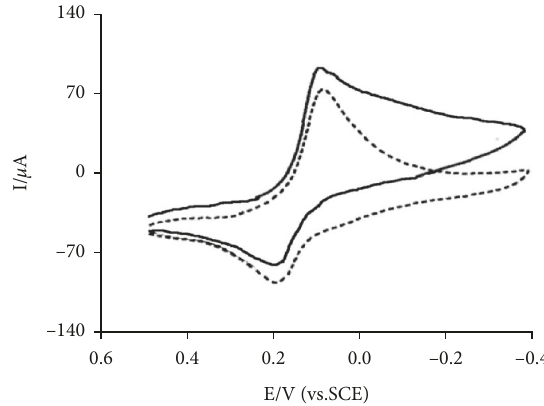
Figure 8: Cyclic voltammograms of the PB-modified electrode response to buffer solution before (dash line) and after (solid line) adding 0.01M hydrogen peroxide.